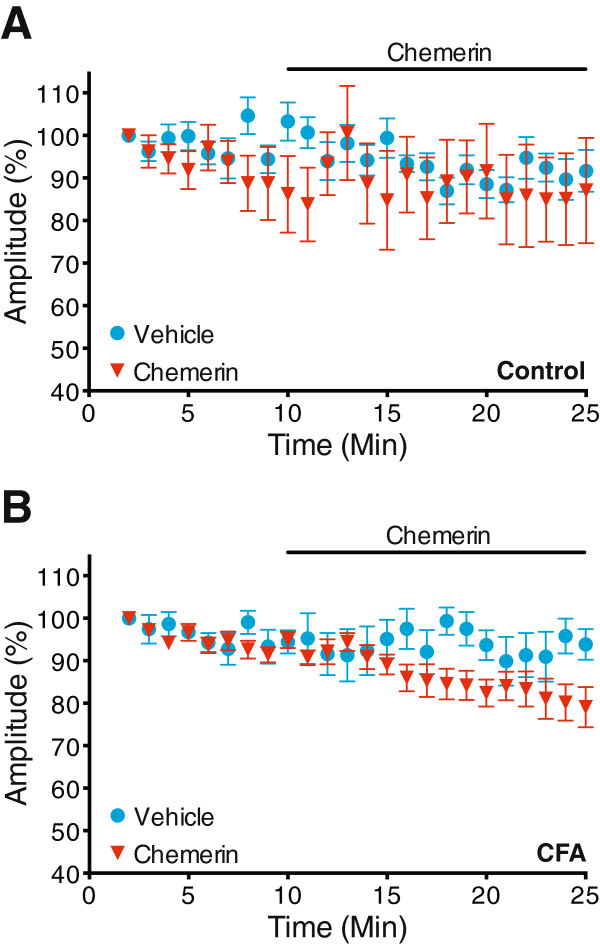
Chemerin does not alter monosynaptic C-fibre eEPSCs in the overall lamina I NK1R+ neuronal population. A. Chemerin (100 ng/ml) does not alter the peak amplitude of monosynaptic C-fibre eEPSCs in control tissue (P = 0.502, chemerin n = 7, vehicle n = 8), although there is a significant decline in peak amplitude over time (P = 0.013). B. In tissue isolated from CFA treated rats, there is no difference in the monosynaptic C-fibre eEPSCs between chemerin and vehicle groups (P = 0.152, chemerin n = 16, vehicle n = 7), although there is a significant reduction in peak amplitude over time (P < 0.0001) and an interaction between these factors (P = 0.0006). All statistics = 2-way repeated measures ANOVA. All data presented as mean ± SEM.